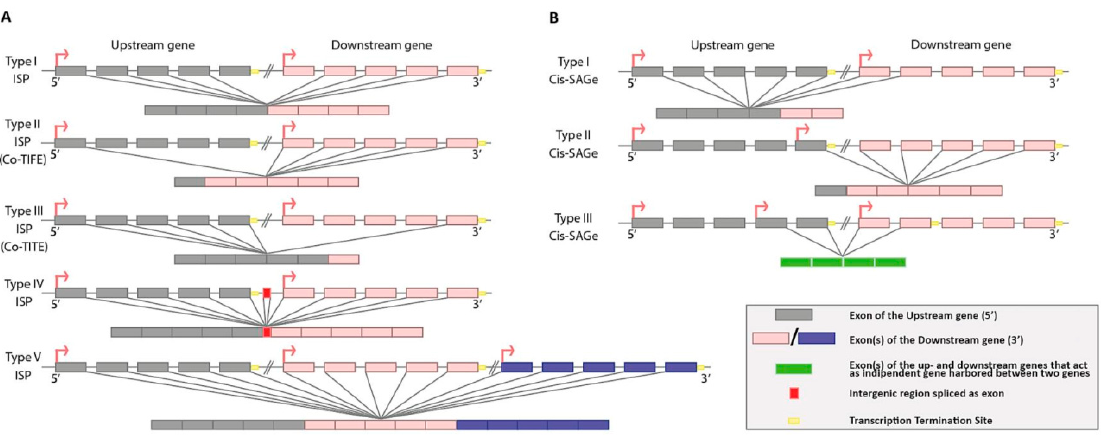
Figure 1. Schematic representation of di ff erent fusion transcripts of adjacent genes (FuTAGs) structures according to Lu et al. [12] and Yuan et al. [9] shown, respectively, in ( A ) and ( B